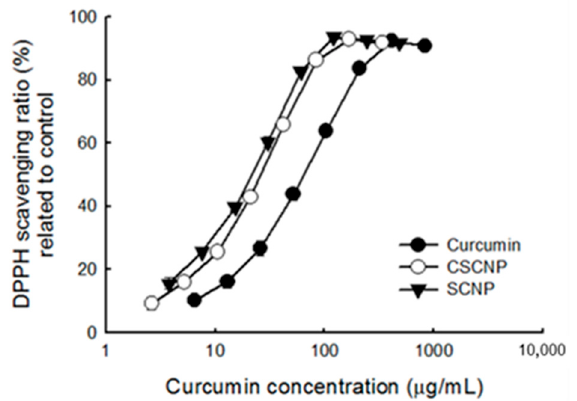
Figure 6. DPPH scavenging ability of curcumin, SCNP, and CSCNP after irradiated with an ultraviolet (UV-C) 30W lamp overnight (about 10 h). Data were shown by mean ± SD of 3 independent experiments ( n = 3) with 3 technical replicates. DPPH: 2, 2-diphenyl-1-picrylhydrazyl; SCNP: silica-encapsulated curcumin nanoparticles; CSCNP: chitosan with silica co-encapsulated curcumin nanoparticles. Table 4. Comparisons of DPPH scavenging EC 50 of curcumin, SCNP, and CSCNP while with and without UV irradiation ( μ g/mL).